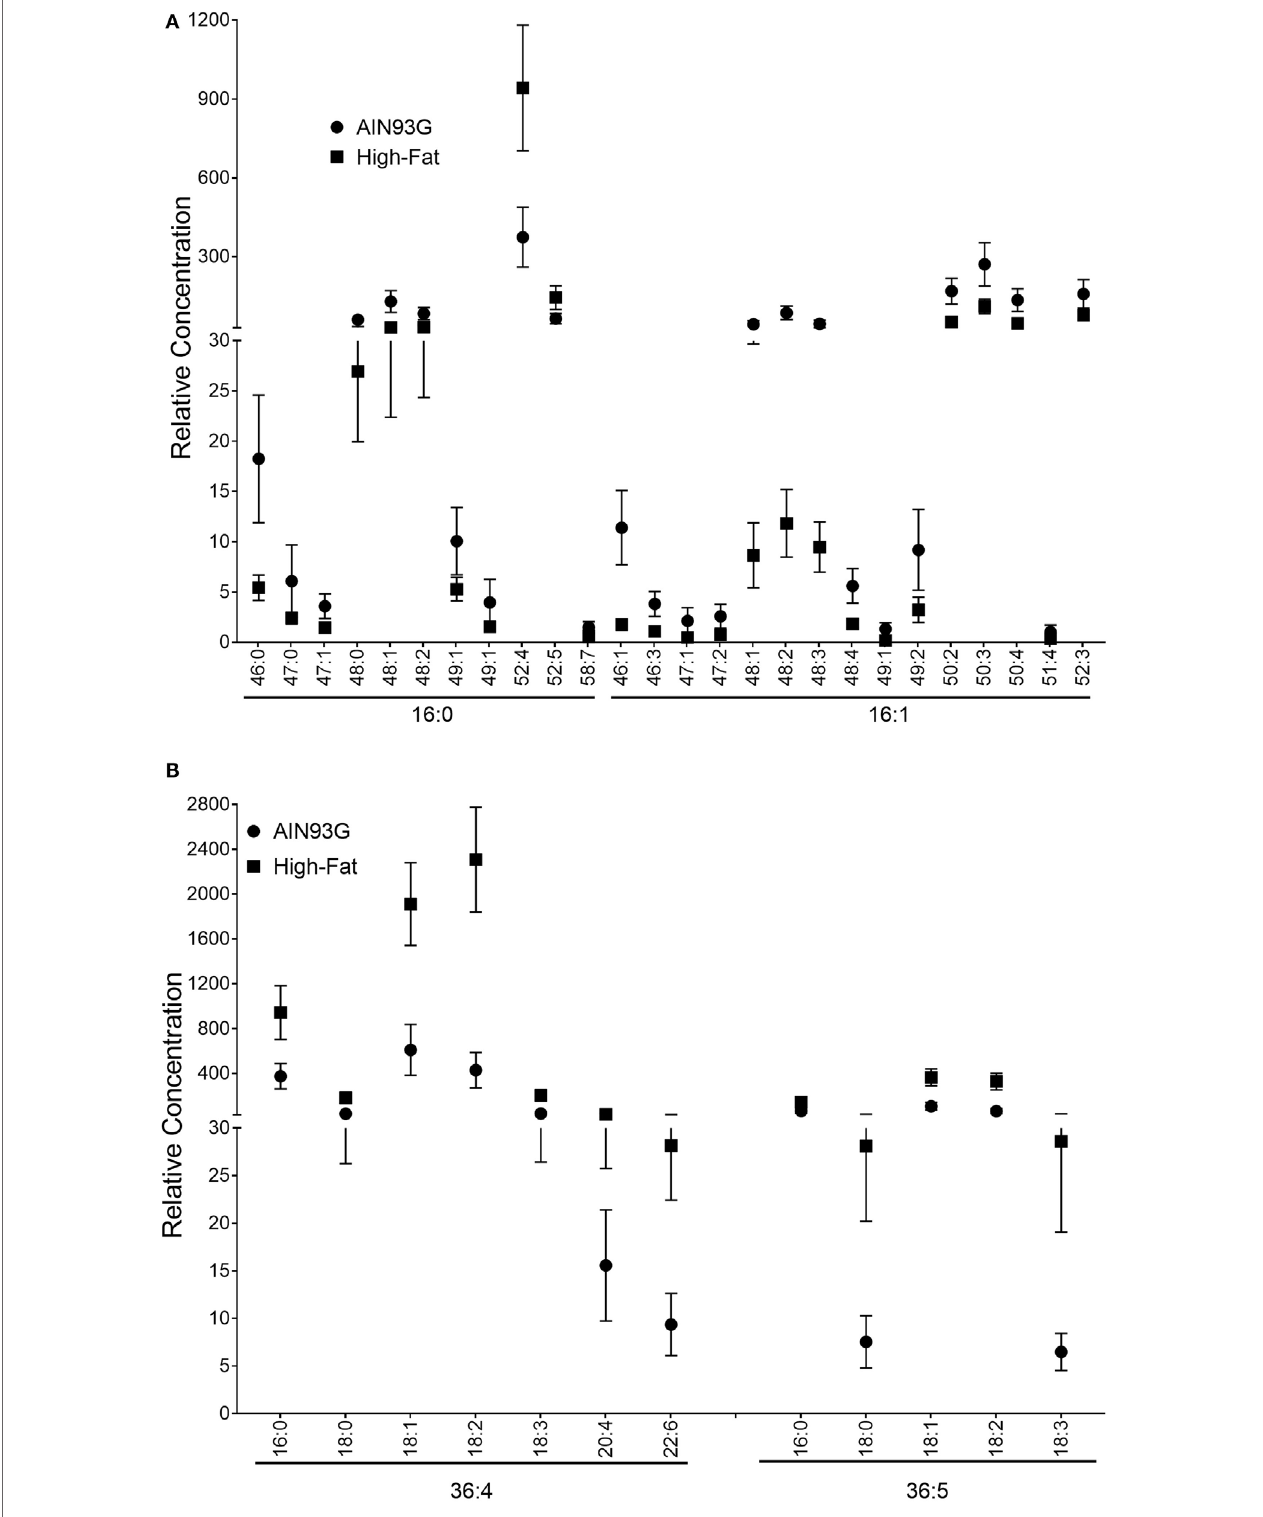
FigUre 8 | Relative concentrations of triacylglycerols (TAG) corresponding to the fatty acids that contribute to significant ( p ≤ 0.05) concentration changes including16:0 and 16:1 (a) and subtracted from brutto structure including 36:4 and 36:5 (b) in the primary tumor of Lewis lung carcinoma from mice fed the AIN93G diet or the high-fat diet (HFD). Values are mean ± SD ( n = 5 for the AIN93G group and n = 6 for the HFD